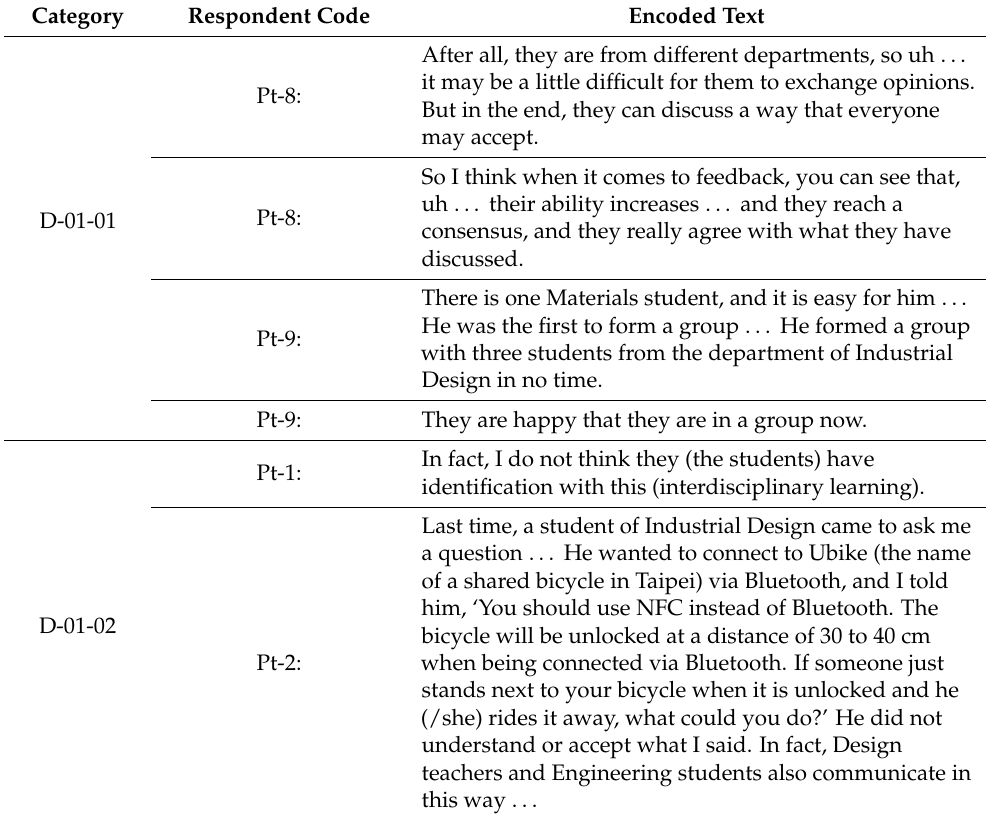
Table A2. Coding of D-01 Learning Condition